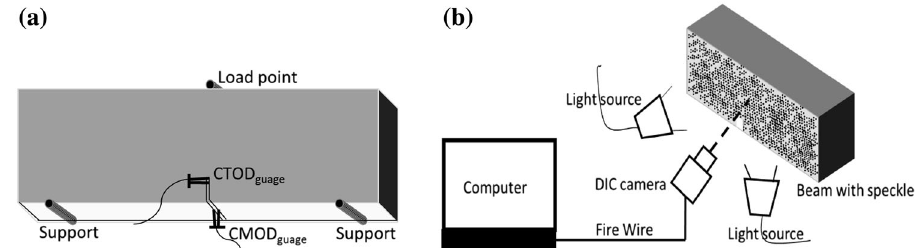
Fig. 1 Experimental setup for flexure test of notched specimens: a schematic sketch showing the placement of gauges; b schematic representation of the DIC setup for obtaining images from the front face during flexure